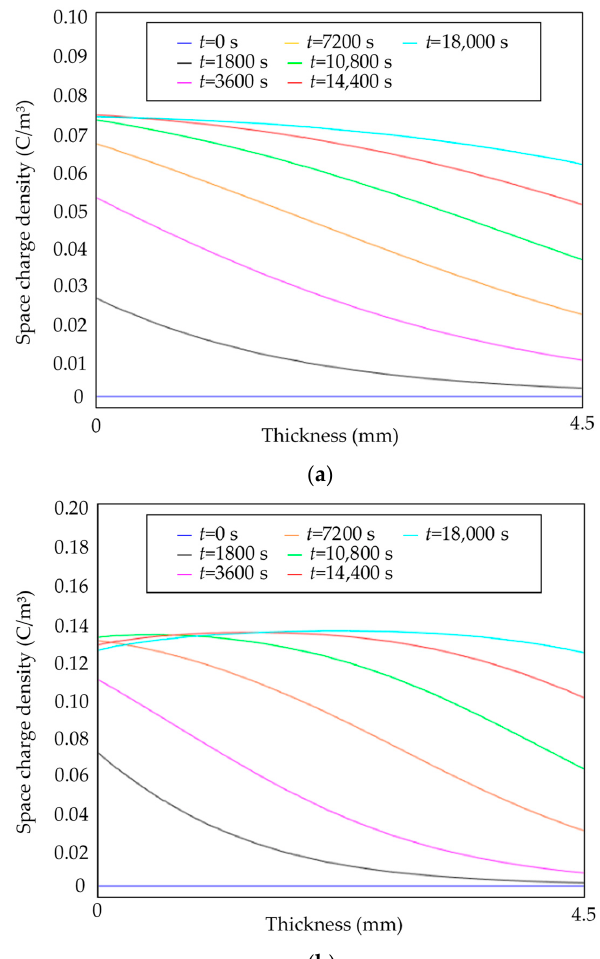
Figure 9. Simulation results under the applied DC voltage of 67.5 kV: ( a ) insulation with the temperature difference of 15 °C; ( b ) insulation with the temperature difference of 30